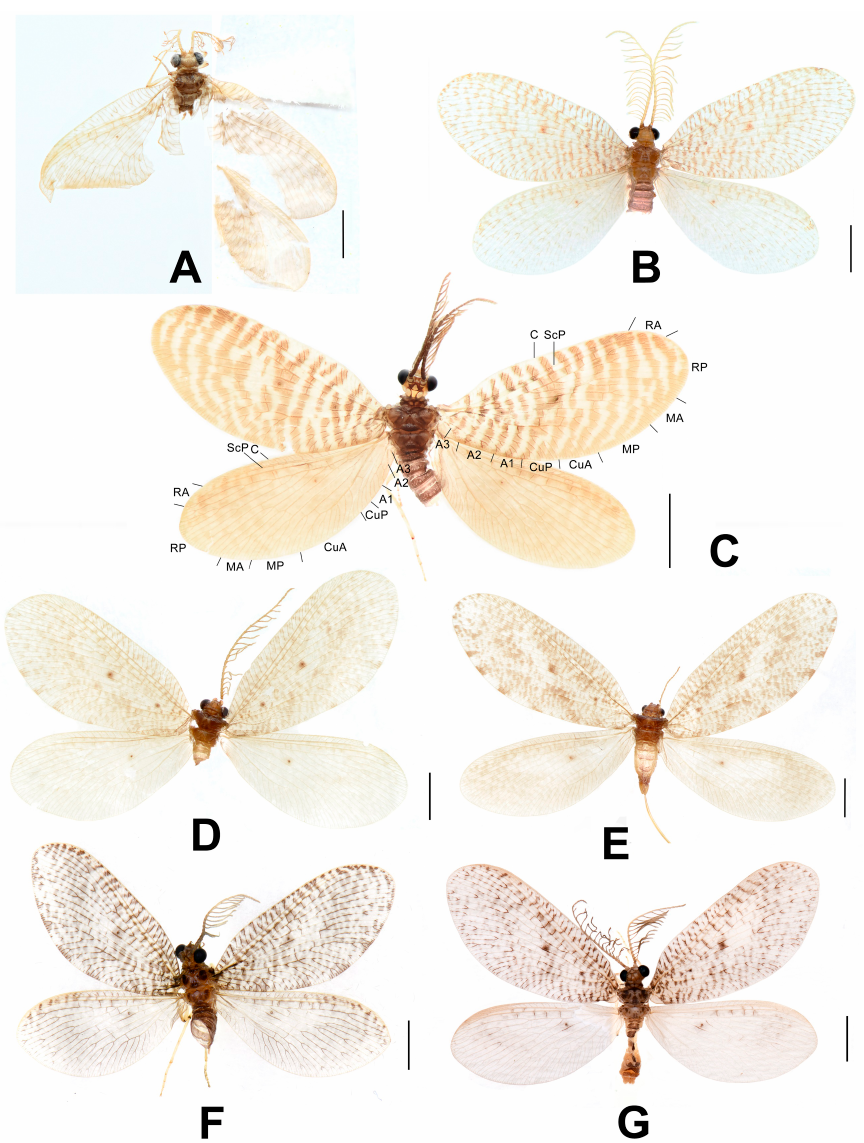
Figure 2. Adults of Dilar spp. ( A ) Dilar phraenus sp. nov., male holotype; ( B ) Dilar rauschorum sp. nov., male holotype; ( C ) Dilar striatus sp. nov., male holotype; ( D ) Dilar weibaoshanensis sp. nov., male holotype; ( E ) Dilar weibaoshanensis sp. nov., female; ( F ) Dilar yucheni sp. nov., male holotype; ( G ) Dilar zhangweiae sp. nov., male holotype. Scale bars: 2.0 mm.